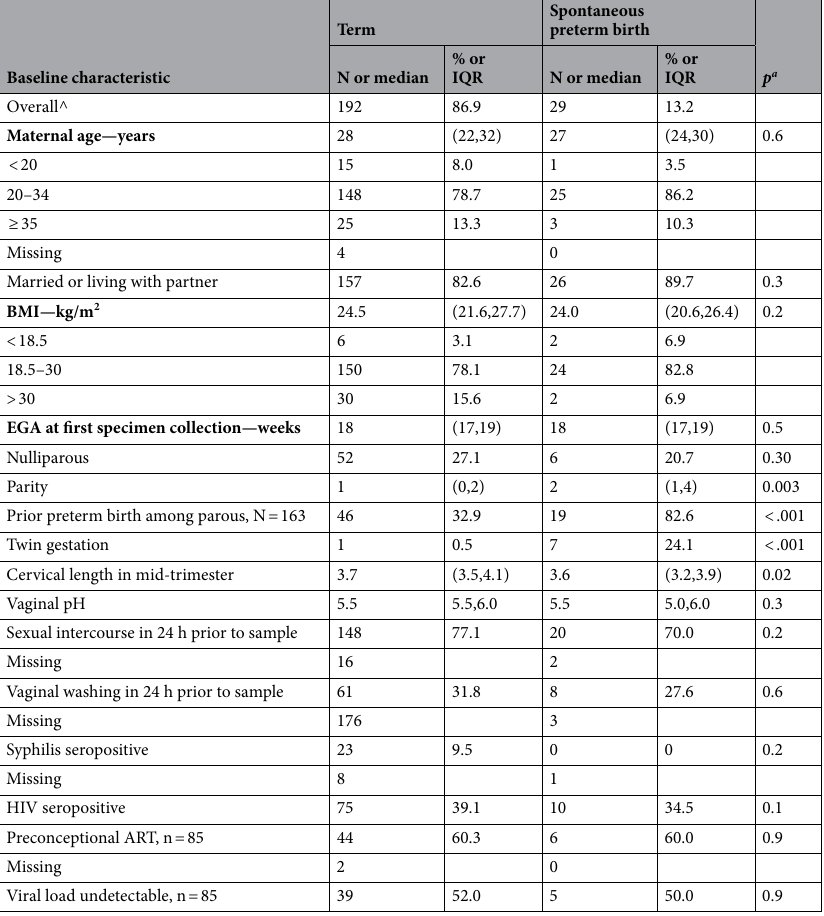
Table 1. Characteristics of participants with vaginal specimens analyzed in ZAPPS cohort, N = 221. BMI, body mass index; EGA, estimated gestational age; ART, antiretroviral therapy; IQR, interquartile range. a p values calculated compared to term births by χ 2 for categorical and linear regression for continuous comparisons, weighted for